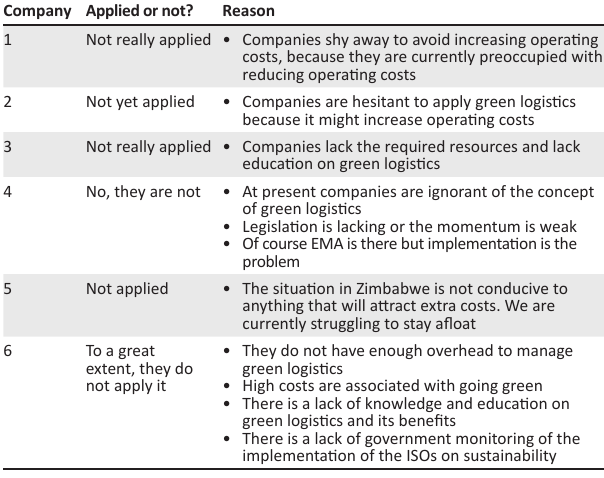
FIGURE 3: A hierarchical analysis of green logistics barriers. TABLE 2: Application and reasons for green logistics application in small and medium-sized enterprises. Company Applied or